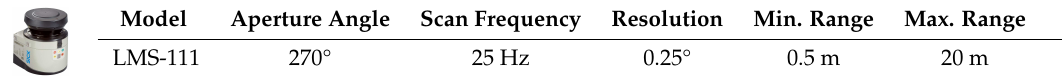
Table 3. The LRF used in